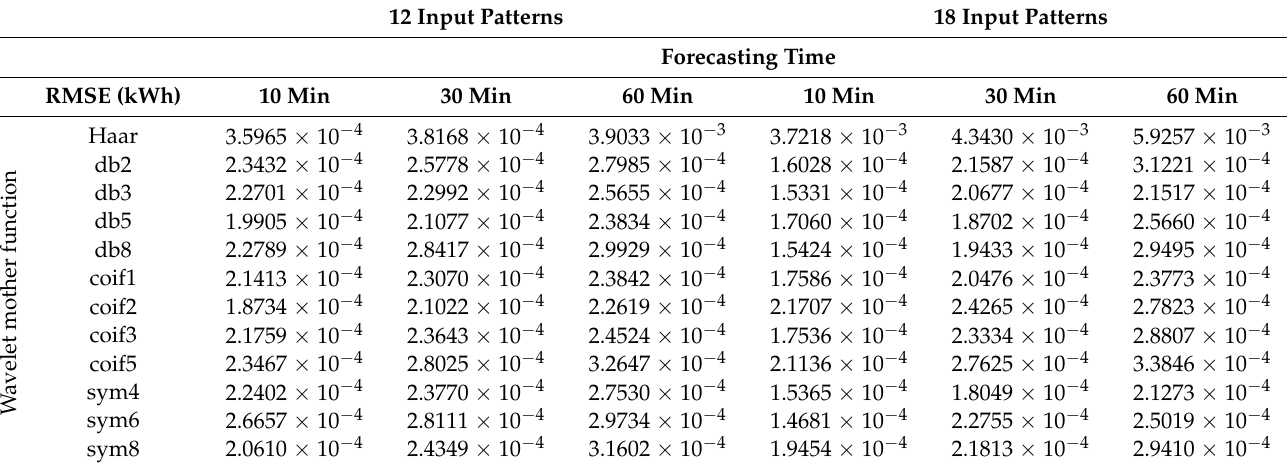
Table 2. Different wavelet-ANFIS with mother function performance.